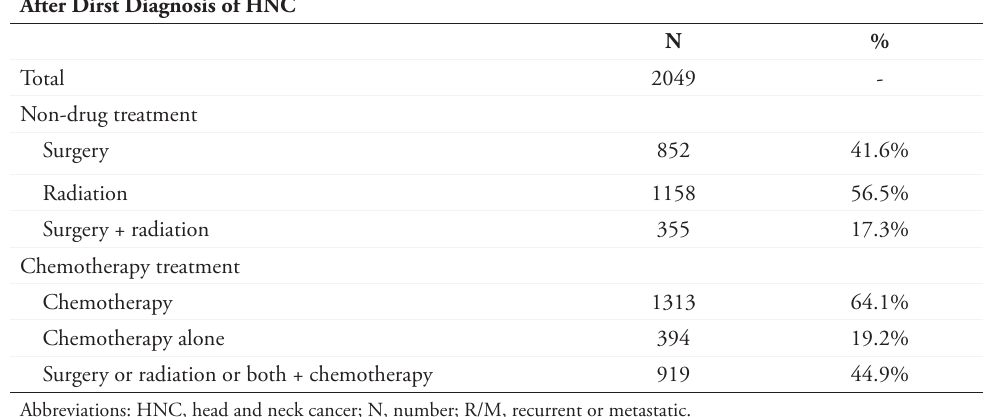
Table 2. Proportion of R/M HNC Patients with Surgery, Radiation, or Chemotherapy Within 6 Months